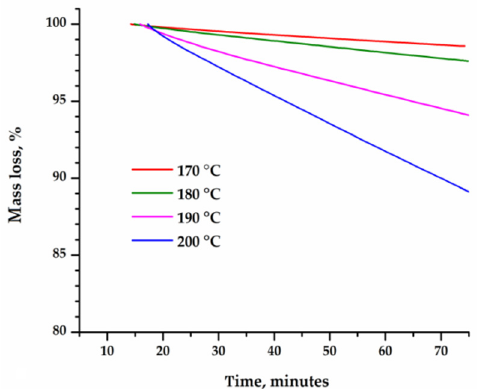
Figure 4. Percentage loss of mass over time for the sublimation of theophylline at various temperatures: 170, 180, 190 and 200 °C.